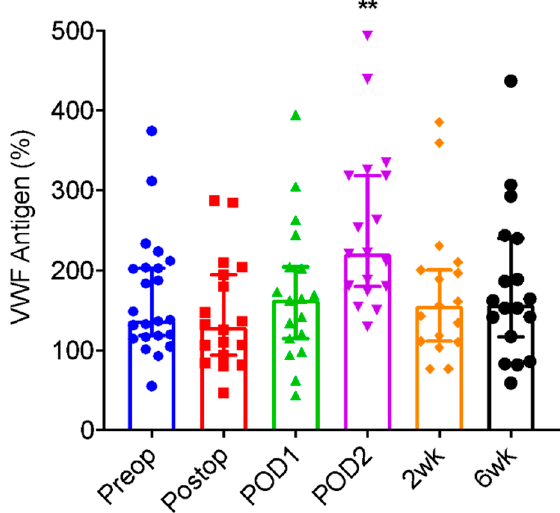
Figure 2. von Willebrand factor (VWF) antigen in patients before and after Joint Arthroplasty. Plasma levels of VWF antigen in patients before (Preop), immediately (postop), one day (POD1), two days (POD2), two weeks (2 wk), and six weeks (6 wk) after elective joint arthroplasty. Each dot represents a result from each patient. The vertical bars are the medians (±95% confidence interval). Here, ** indicates p < 0.01. Table 2. Plasma levels of ADAMTS13 (A Disintegrin And Metalloprotease with Thrombospondin type 1 repeats, 13), von Willebrand factor (VWF), and ADAMTS13/VWF ratios in patients before and after joint arthroplasty.